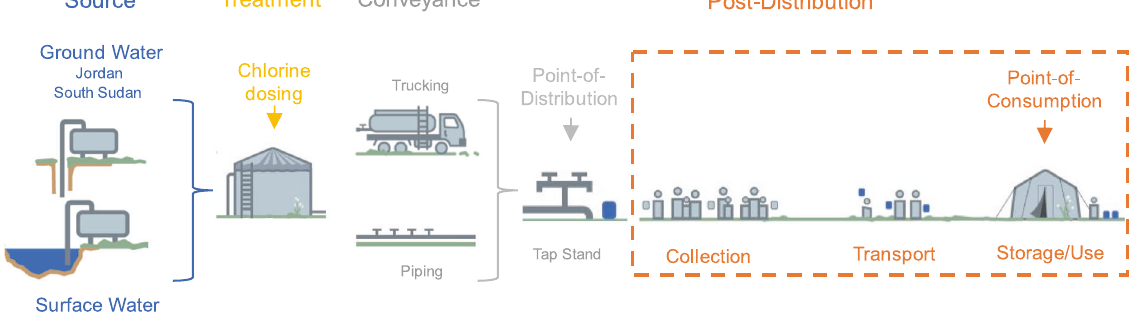
Fig. 1 Post-distribution period shown in context of overall water supply system for typical refugee or IDP settlement. Water obtained from ground or surface water is centrally treated then conveyed via piped distribution system to the tap stand (point-of-distribution). The post-distribution period begins when water is collected from the tap stand and continues as it is transported to the household and then stored until use